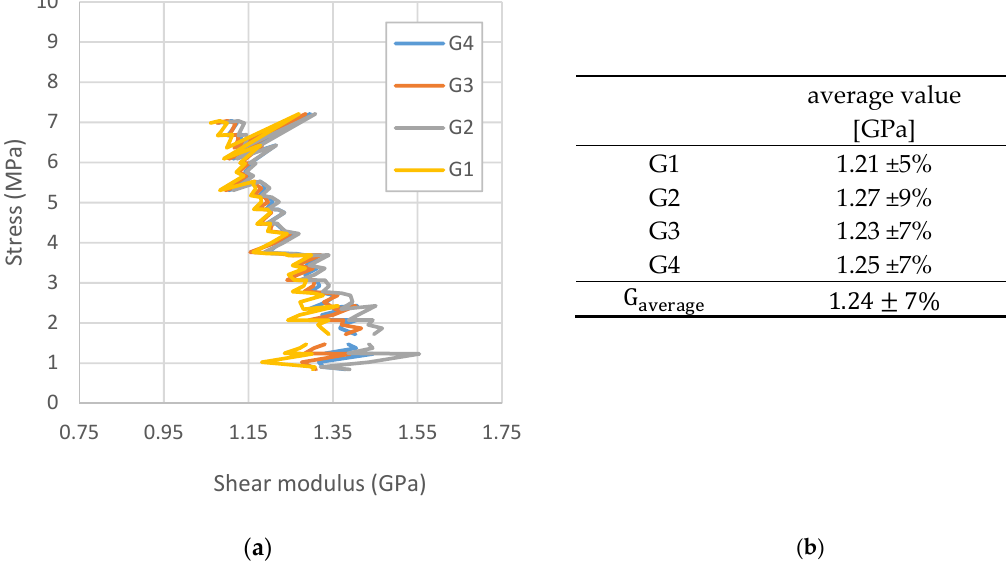
Figure 9. Determination of the average value of the shear modulus.